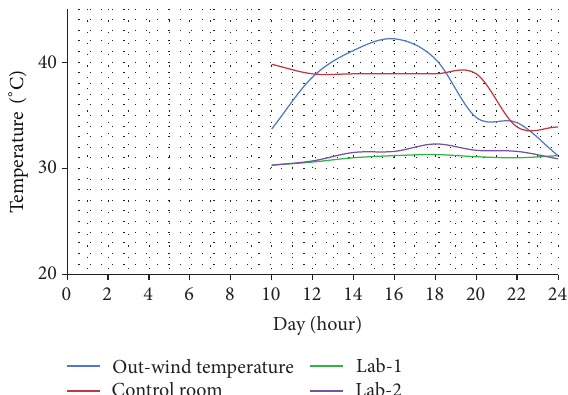
Figure 3: A typical day temperature chart during the wet season months of September and October. “Out-wind temperature” is the temperature of outside environment; “control room” is the ambient temperature of the control ward; “Lab-1” is the ambient temperature of Lab-1; “Lab-2” is the ambient temperature of Lab-2.